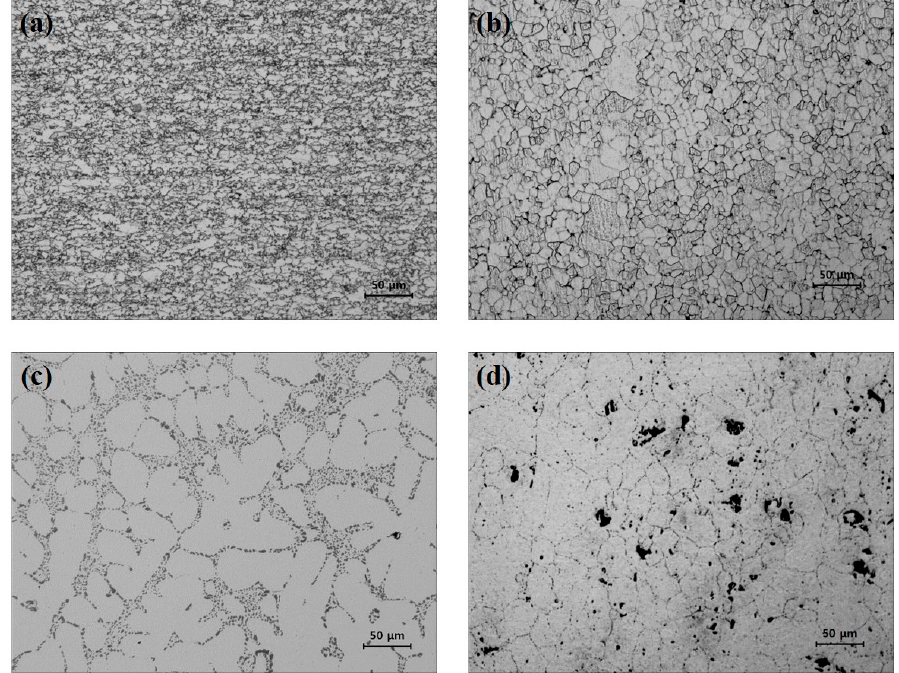
Figure 1. OM images of the microstructures of ( a ) DP590, ( b ) SS330, ( c ) A356, and ( d ) A5052.